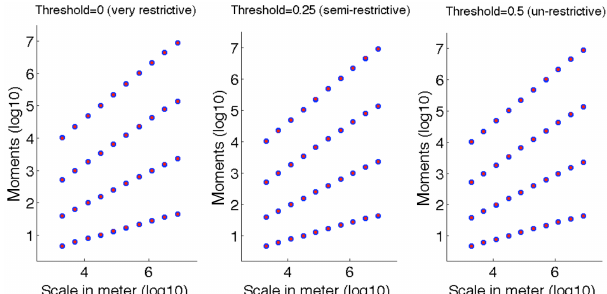
Figure A3. Statistical moments of order q = 0 . 5, q = 1, q = 1 . 5 and q = 2 computed for biased and unbiased synthetic data at dif- ferent scales. From left to right, the threshold is R = 0, 0.25, and 0.5 from the more to the less restrictive. Blue points stand for the regu- lar reference data. Red points represent irregular series (all ratios). Red points are satisfyingly centered inside blue points, regardless of the threshold. Therefore, the kind of irregularity that occurs in real data does not significantly impact the quality of Haar analysis.